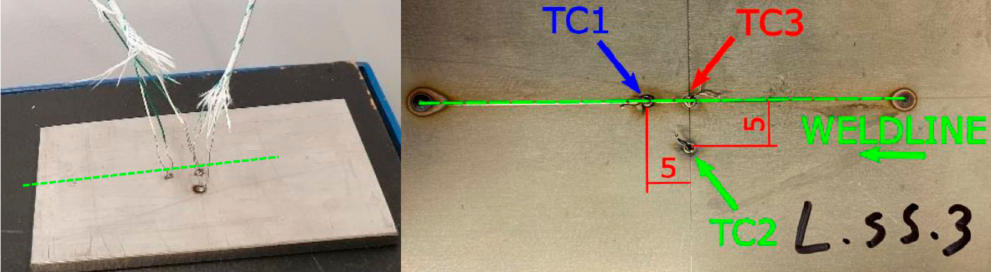
Figure 10. Diagram of the location of thermocouples relative to the bead axis at the bottom of the test